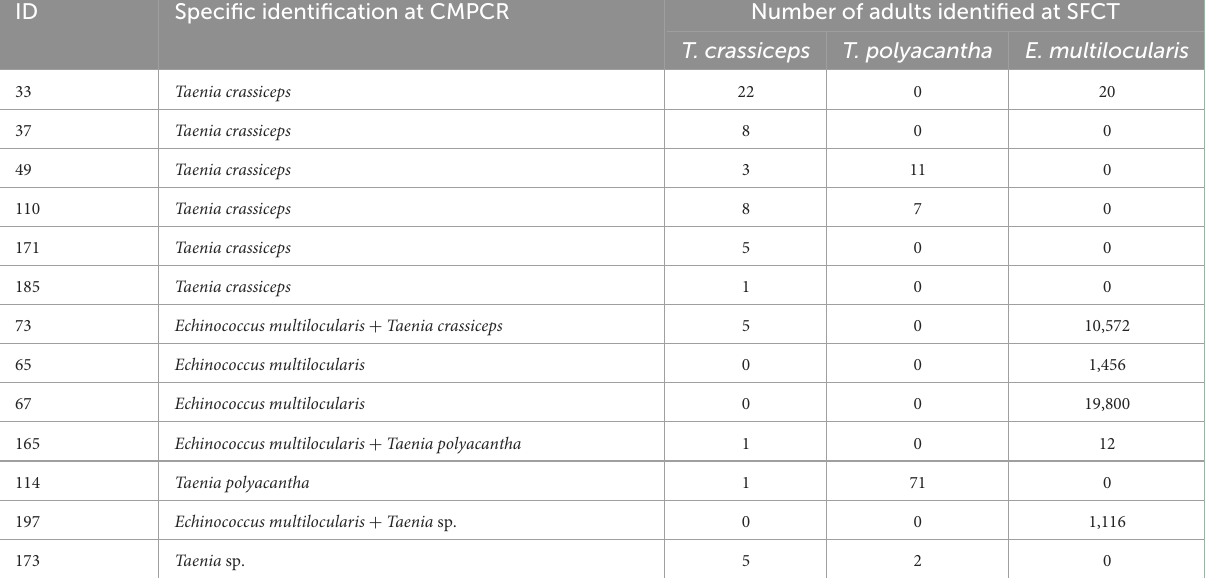
TABLE 3 Number of retrieved adult parasites and specific identification at SFCT (scraping, filtration and counting technique) for the 13 animals positive for Taeniidae molecularly identified at CMPCR (multiplex PCR).